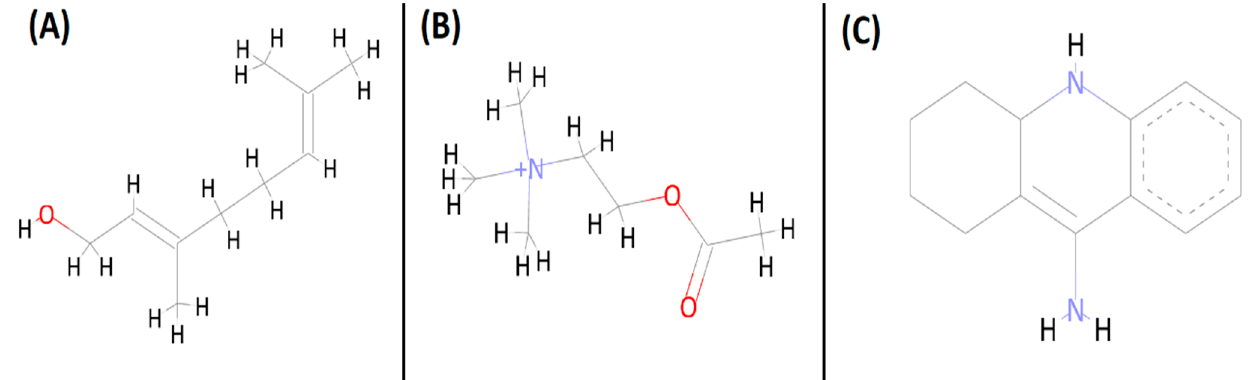
Figure 1. Two ‐ dimensional structure of geraniol ( A ), acetylcholine ( B ), and tacrine ( C ). Figure 1. Two-dimensional structure of geraniol ( A ), acetylcholine ( B ), and tacrine ( C